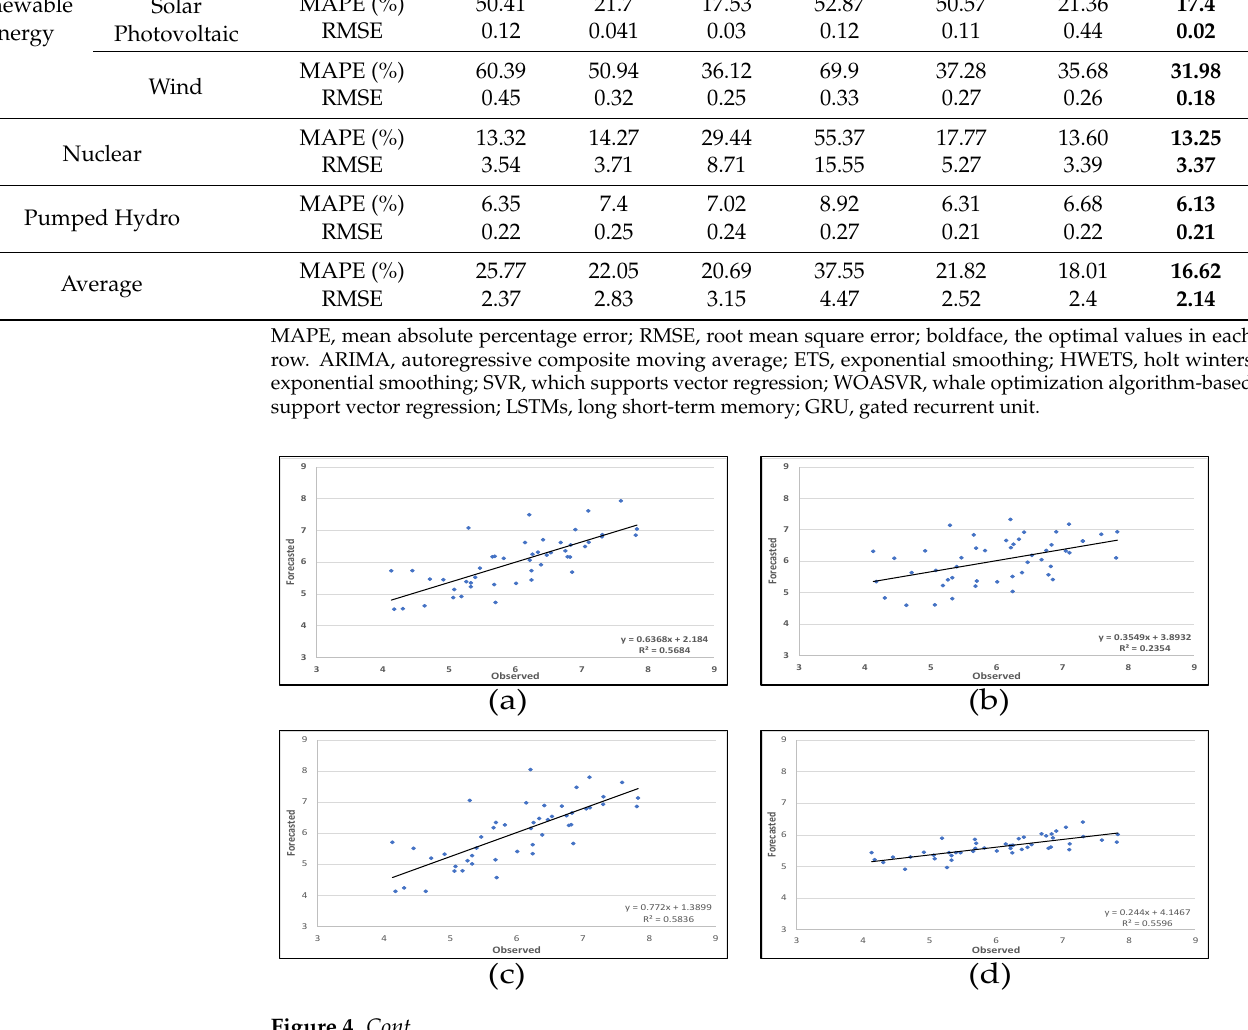
Figure 4. Scatter plots of the predictions obtained for coal energy generation (48 − month forecasts) for the period from 1 January 2017, to 31 December 2020, when different methods were used: ( a ) autoregressive composite moving average (ARIMA), ( b ) exponential smoothing (ETS), ( c ) Holt − Winters ETS (HWETS), ( d ) SVR, ( e ) WOASVR, ( f ) long short-term memory (LSTM), and ( g ) GRU.